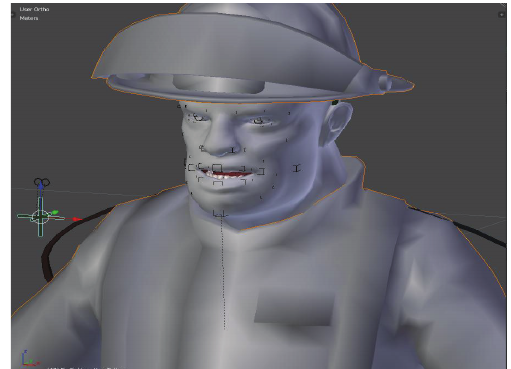
Figure 5: Face animation